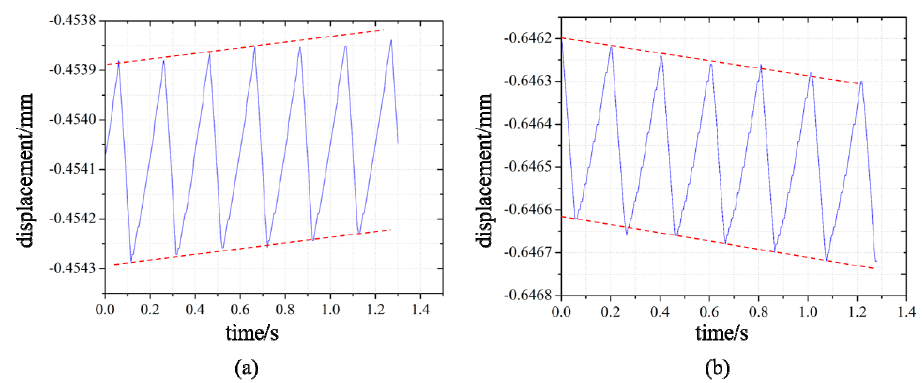
Figure 15. Displacement curves of the stage with diferent vertical loads: ( a ) vertical load of 72 g; ( b ) vertical load of more than 72 g.